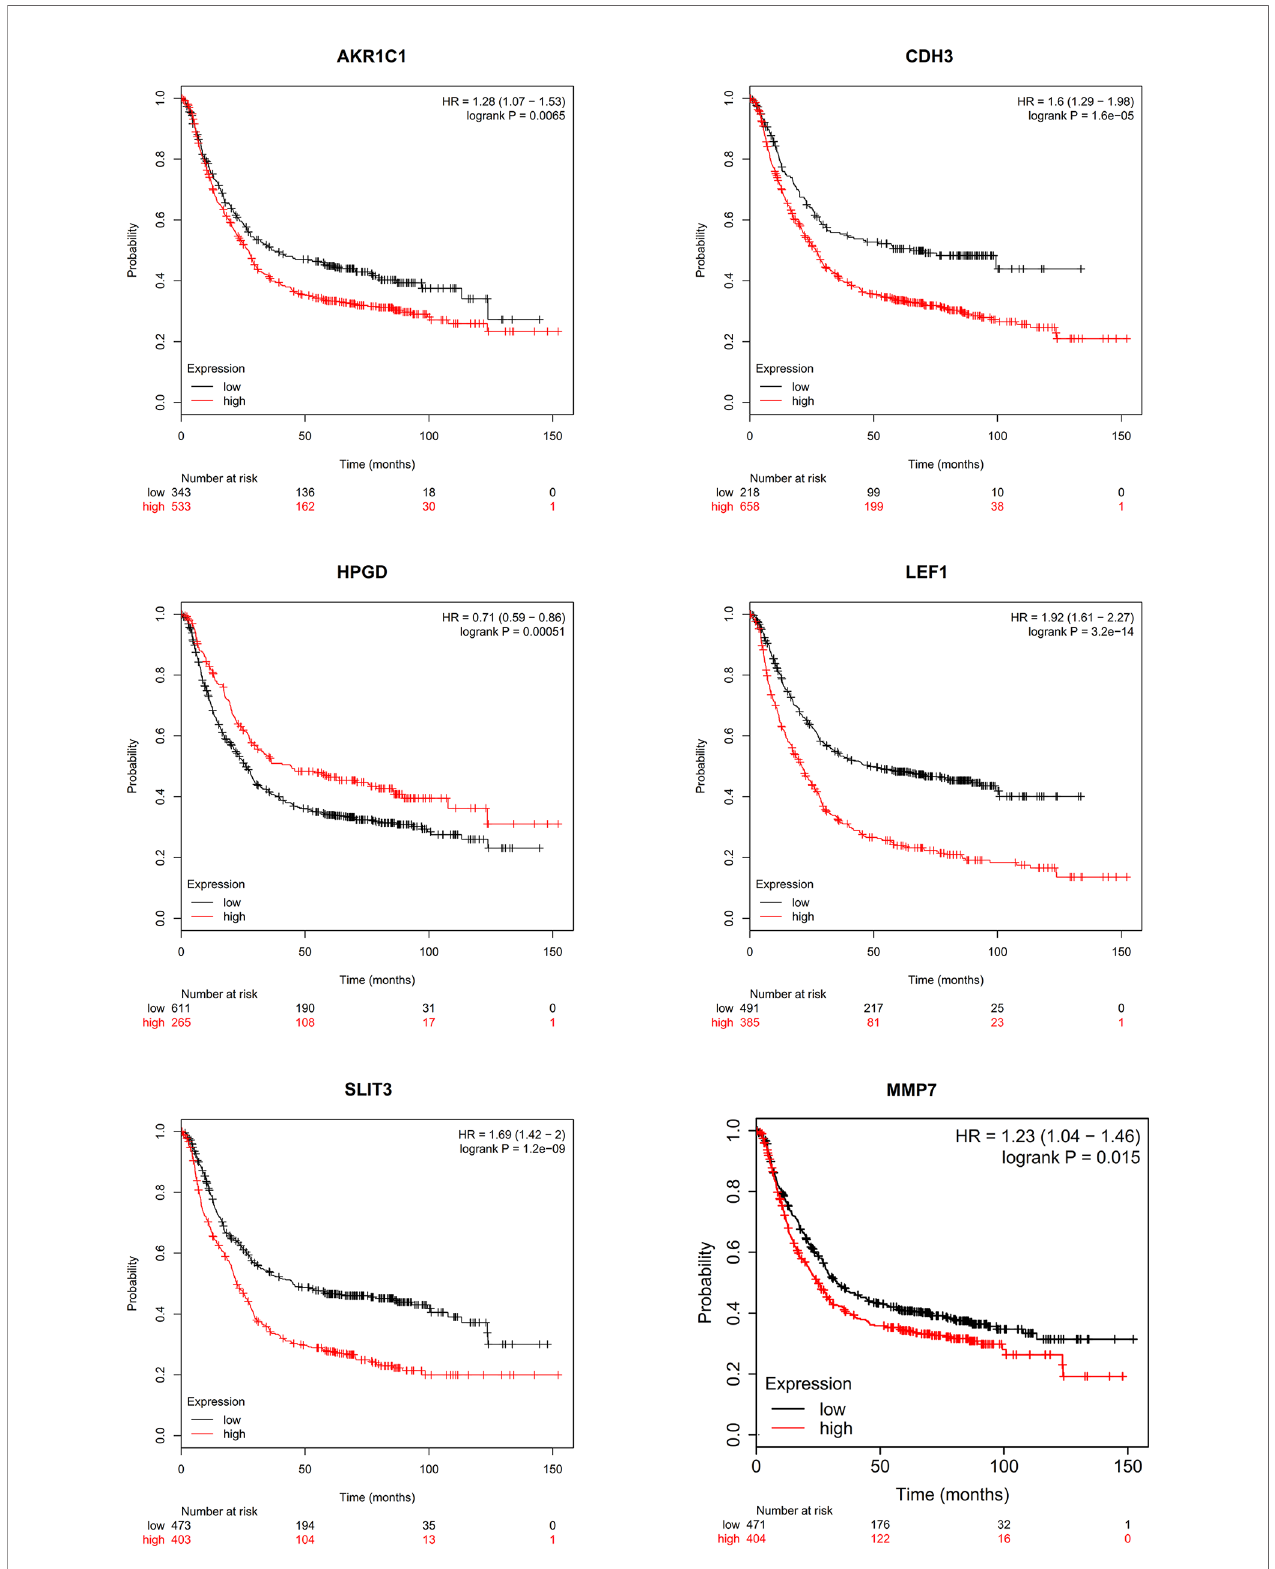
FIGURE 9 | Survival analysis of hub